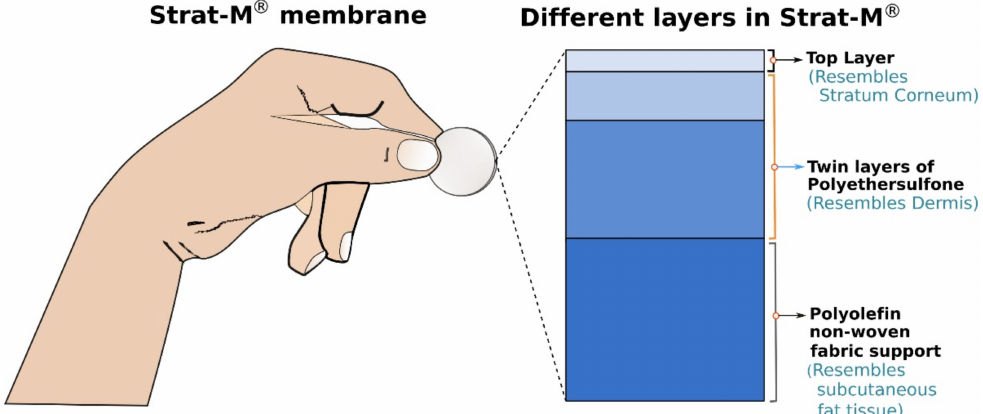
Figure 3. A Strat-M ® membrane and the representation of different